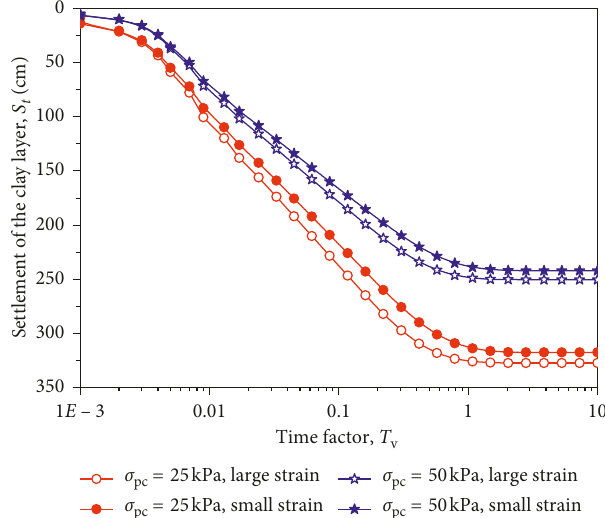
Figure 13: Influence of geometric supposition on S